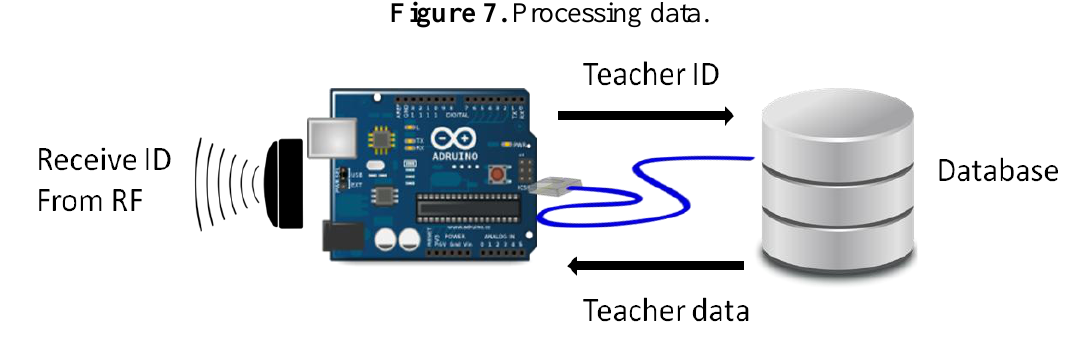
Figure 7. Processing